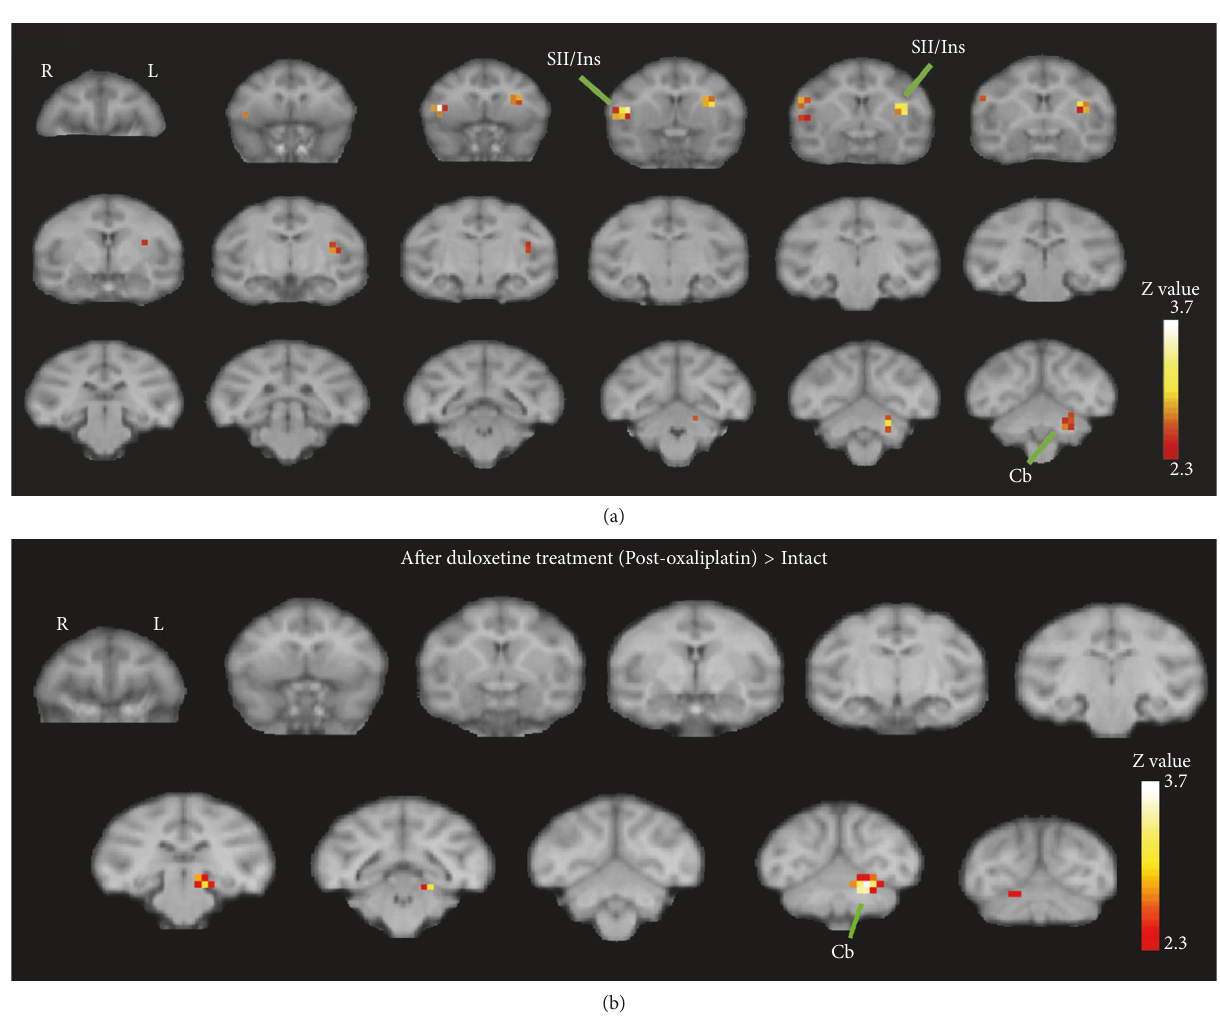
Figure 2: Cold stimulation evokes brain activation in oxaliplatin-treated macaques, which is attenuated with duloxetine. Before and three days after oxaliplatin treatment, brain activation was visualized with a 3.0 T Philips Healthcare MRI system in propofol-sedated macaques [42]. Alternating temperatures (cold, 10 ° C and neutral, 37 ° C) were applied to the tail for 30sec. each with a 30sec. interval without stimulation. (a) Cold stimulation in oxaliplatin-treated macaques activated secondary somatosensory cortex (SII) and insula (Ins). Ac- tivation in the left cerebellum (Cb) following cold stimulation was also observed. Contrast was defined as (10 ° C stimulation − 37 ° C stimulation after oxaliplatin treatment)–(10 ° C stimulation − 37 ° C stimulation before oxaliplatin treatment; “intact”). Peak voxels Z values greater than 3.0 were p < 0 . 001 (uncorrected for multiple comparisons, one-tailed). Coronal sections of oxaliplatin-treated macaques averaged from four macaques. Sections arranged from rostral (upper left) to caudal (lower right) and spaced 2mm apart. R, right; L, left. (b) Duloxetine suppressed cold-induced activation in SII and Ins in oxaliplatin-treated macaques. However, activation in Cb was still present following duloxetine treatment. Three days after oxaliplatin treatment, macaques were dosed with duloxetine (p.o. 30mg/kg) and cold- evoked brain activation was measured one hour following duloxetine treatment. The effect of duloxetine treatment on cold-evoked brain activation in oxaliplatin-treated macaques (“after duloxetine treatment (Post-oxaliplatin)”) was compared to cold-evoked brain activation before oxaliplatin treatment (“intact”). No significant activation in SII and Ins was observed following duloxetine treatment ( p > 0 . 05). Thus, the lack of activity in SII and Ins following duloxetine administration in oxaliplatin-treated macaques was similar to that of macaques prior to oxaliplatin treatment. (An additional analysis was performed comparing cold-evoked SII and Ins activation after and before duloxetine treatment in oxaliplatin-treated macaques (data not shown, [42]). Activation in SII and Ins following duloxetine treatment was significantly suppressed—the difference in peak voxels, between after and before duloxetine treatment, was p < 0 . 001. See [42] for details.) Coronal sections of oxaliplatin-treated macaques averaged from four macaques. Sections arranged from rostral (upper left) to caudal (lower right) and spaced 4mm apart. R, right; L, left. Data previously published in